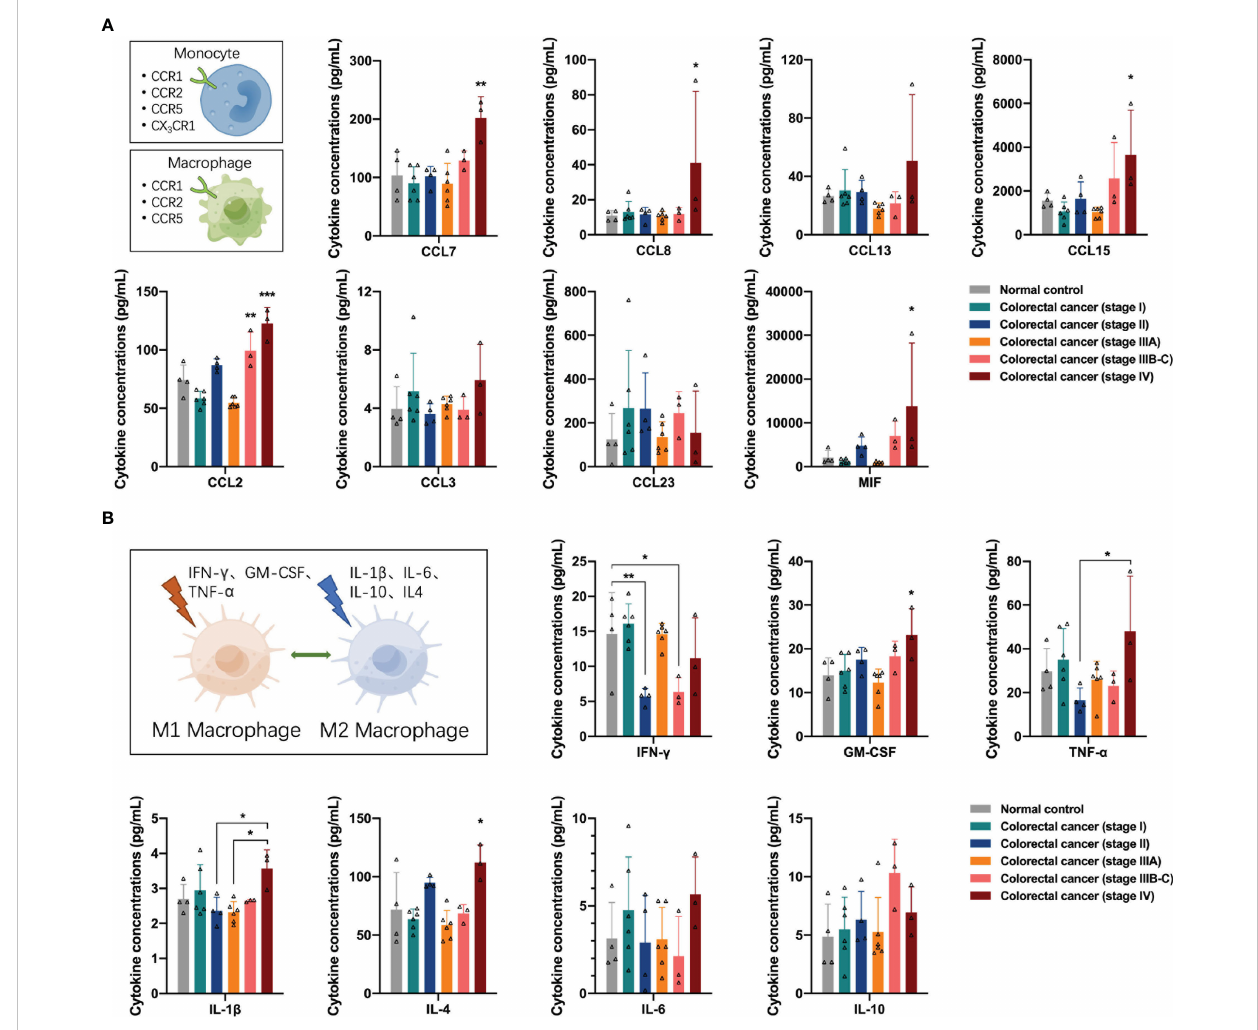
FIGURE 2 Distribution of cytokines associated with the monocyte-macrophage system in the peripheral blood of the participants. (A) Concentrations of CCR1, CCR2, and CCR5 ligands in the peripheral blood of the participants. In colorectal cancer, several monocytes/macrophages are recruited to the tumor region and macrophages are stagnated in the tissues. (B) Concentrations of M1 or M2 polarization-related cytokines in the peripheral blood of the participants. M1 macrophage-mediated anti-tumor function was impaired in stage II and stage IIIB-C colorectal cancer and may restore in colorectal cancer patients with distant metastases. M2 macrophage mediated pro-tumor function in patients with stage VI colorectal cancer. Data are presented as mean±SD, one-way ANOVA, * p <0.05, ** p <0.01, *** p